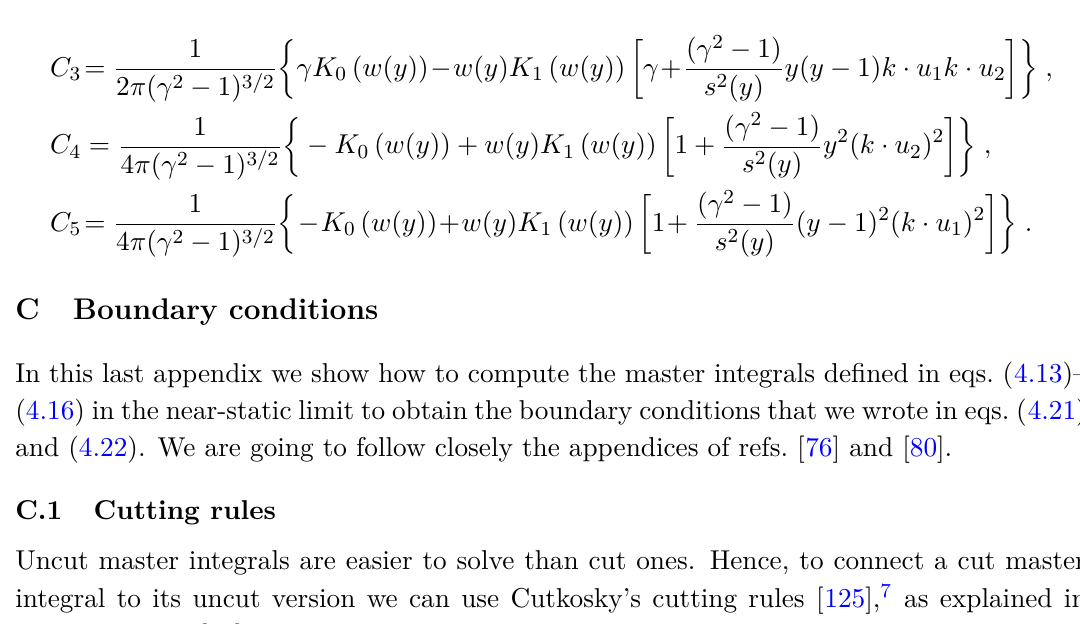
Figure 1 . Representation of the topologies of scalar integrals needed to compute the four master